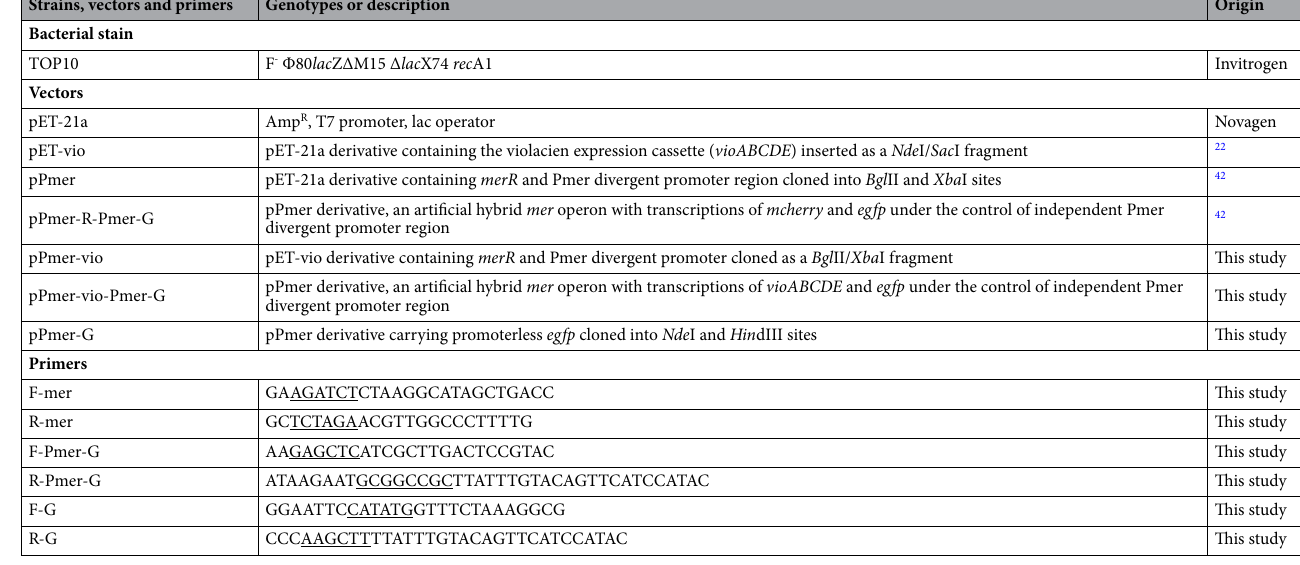
Table 1. Bacterial strains and plasmids used in this